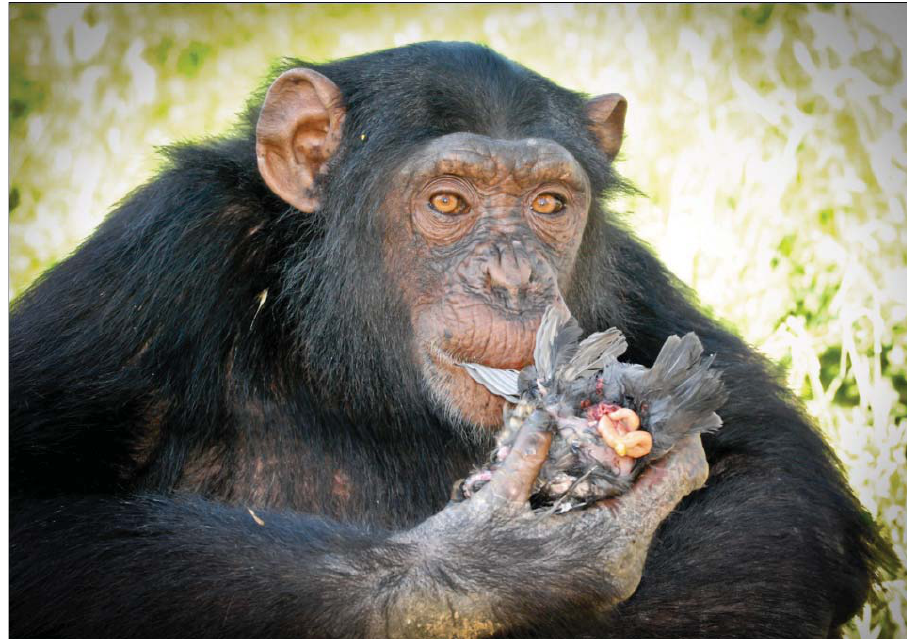
Figure 3. Predation of a Turdus merula (episode H2) by